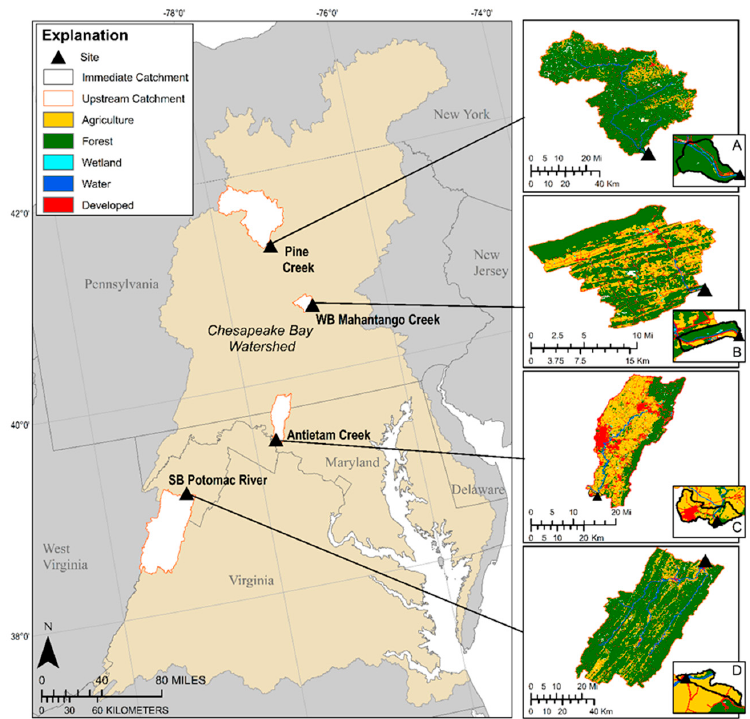
Figure 1. Site locations (Pine Creek, West Branch Mahantango Creek, Antietam Creek, South Branch Potomac River) for smallmouth bass collections and associated land cover in the upstream catchments. Inserts ( A – D ) represent the immediate